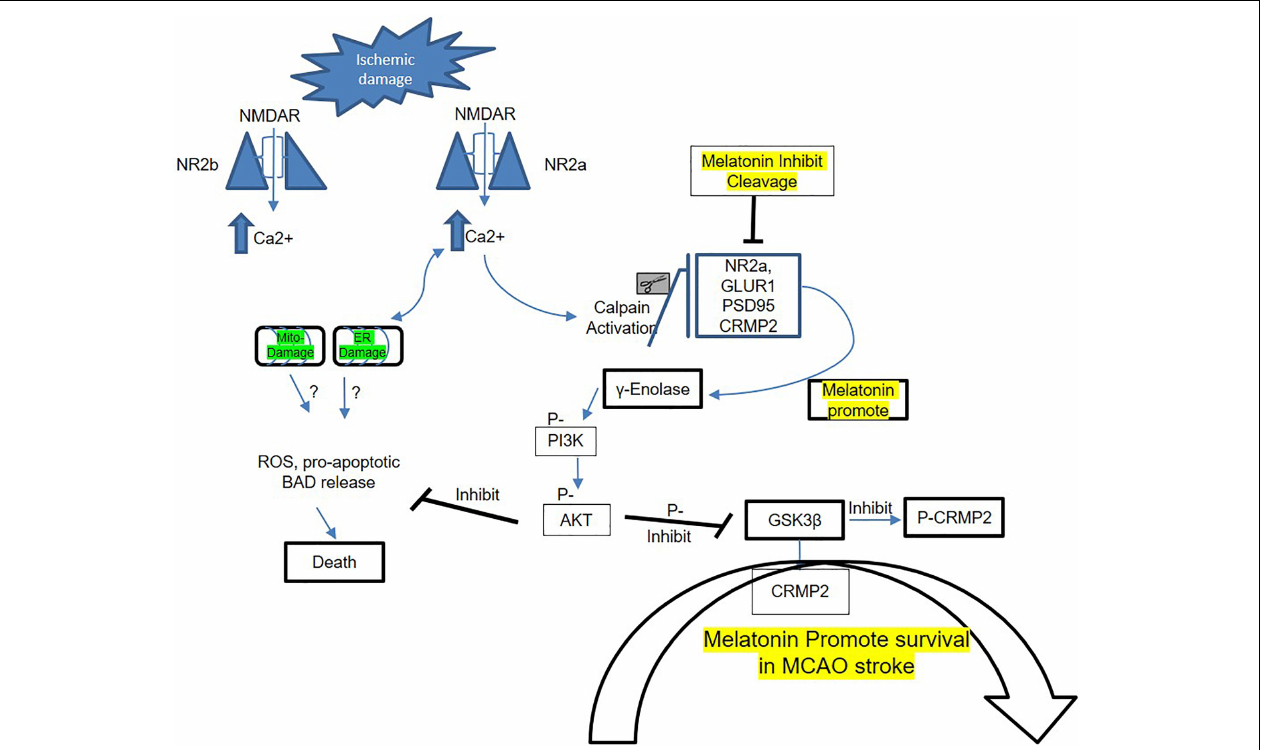
FIGURE 5 | Proposed schematic presentation of melatonin in MCAO stroke. A schematic diagram of suggested neuroprotective mechanism of melatonin in MCAO stroke brain. This diagram shows the possible mechanism by which melatonin prevent MCAO-induced neuronal damage, synaptic deficit, and neurodegeneration through Enolase/PI3K/AKT/CRMP2